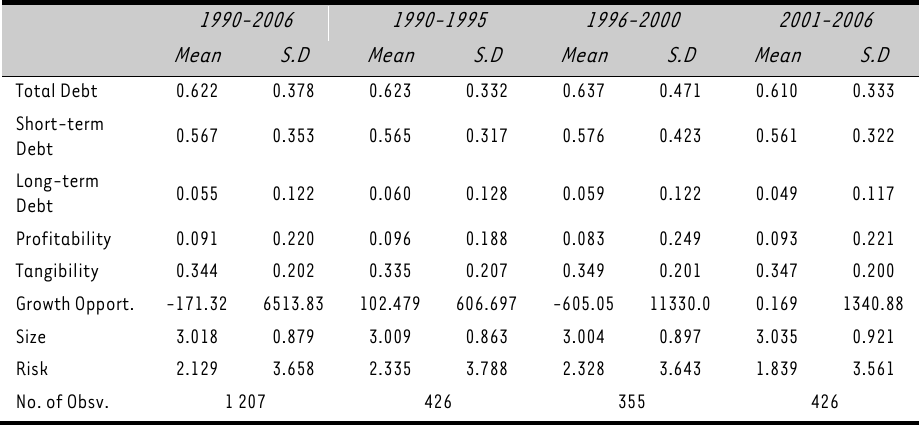
Summary statistics for the debt ratios, profitability and the control variables across different earnings periods 1990-2006